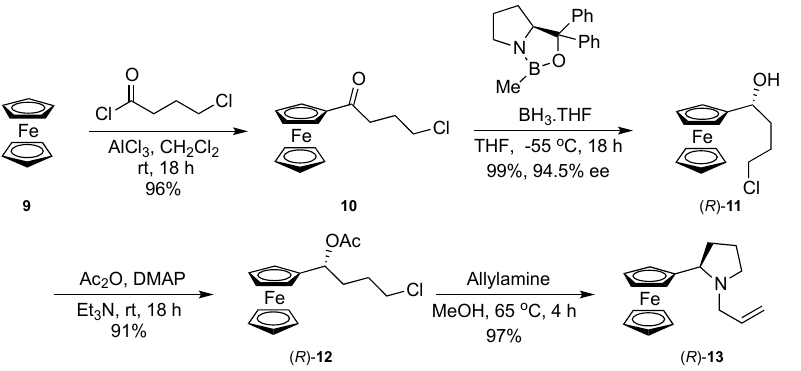
Figure 3. Ferrocenylphosphine-aminophosphine and ferrocenyphosphine-phosphoramidite lig- ands.